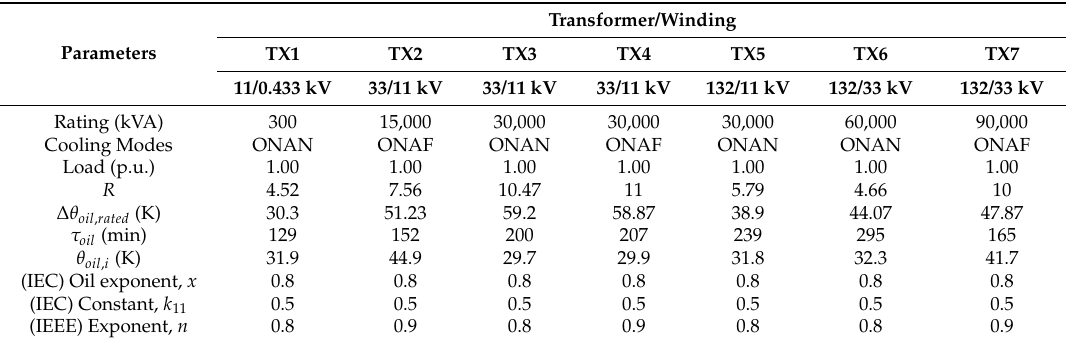
Table 1. Input parameters for the TOT thermal model.